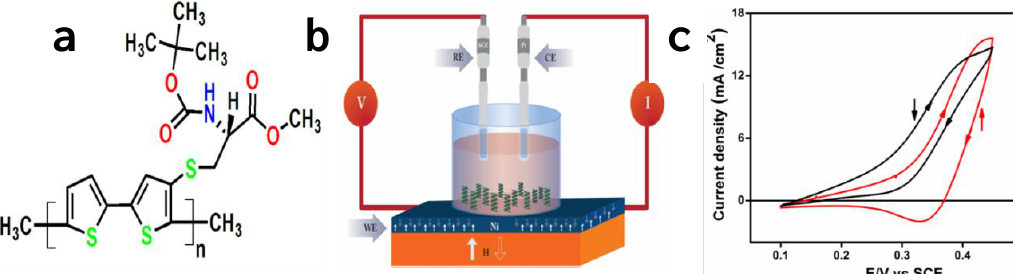
Figure 10. (a) Poly{[methyl N -(tert-butoxycarbonyl)-S-3-thienyl- L -cysteinate]-cothiophene} chemical structure and (b) schematic representation of the spin-dependent electrochemistry setup. The ferromagnetic Ni was coated with chiral polymers and used as the working electrode which can be magnetized by an external magnetic field (H). (c) Spin-dependent cyclic voltammograms recorded on the chiral-polymer-coated Ni working electrode in the presence of achiral ferrocene redox probe measured under magnetic field pointing “UP” (solid red curve) and “DOWN” (solid black curve) by applying a static magnetic field of 0.35 T (Reproduced with permission from [33], WILEY-VCH, 2015).